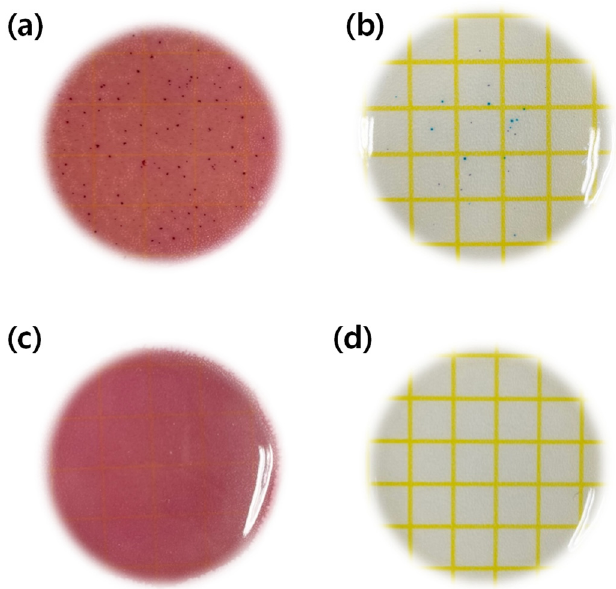
Figure 9. Antimicrobial test of samples. ( a ) Escherichia coli test of Ref sample, ( b ) Staphylococcus aureus test of Ref sample, ( c ) Escherichia coli test of M0.1N5S1 sample, ( d ) Staphylococcus aureus test of M0.1N5S1 sample.